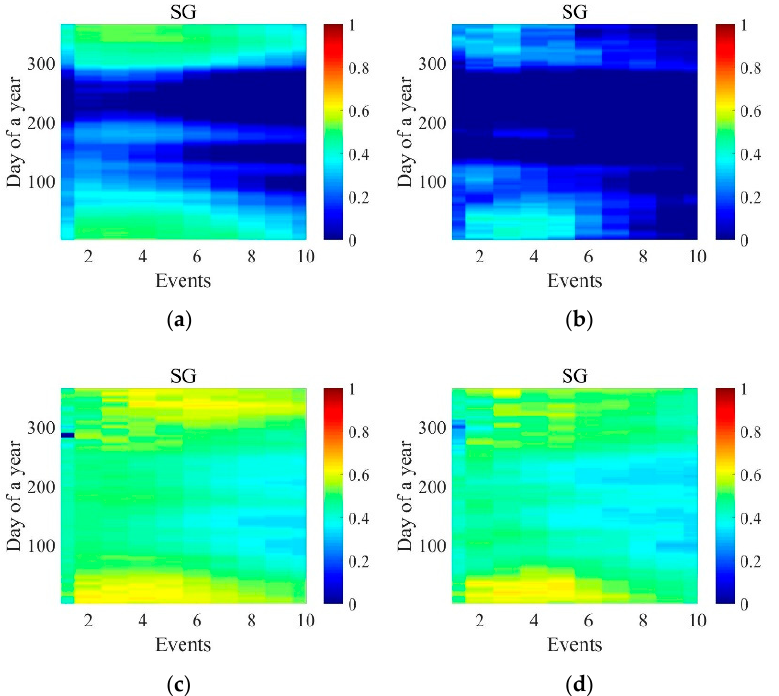
Figure 11. The CRPSS results of Scheme 2 for Shaoguan: ( a ) raw GEFS; ( b ) raw CFSv2; ( c ) post-processed GEFS; and ( d ) post-processed